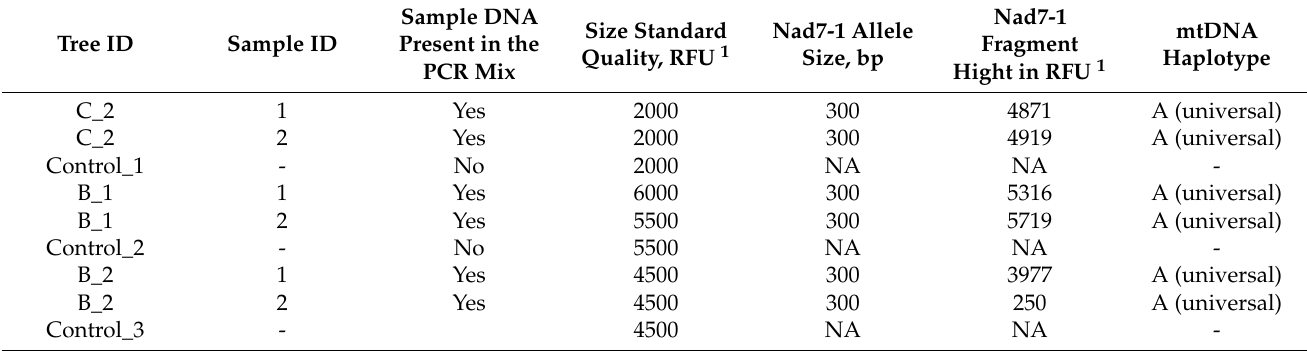
Table 3. PCR amplification of the alleles at the Nad7.1 locus for the three ancient Scots pine trees found in the Baltic sea. Controls are the DNA-free samples containing the same constituents and included in the PCR and capillary electrophoresis runs together with the ancient pine. NA—no amplification of DNA of any kind above 10 RFU. Sample ID refers to two independent samples from a single wood specimen (individual tree).